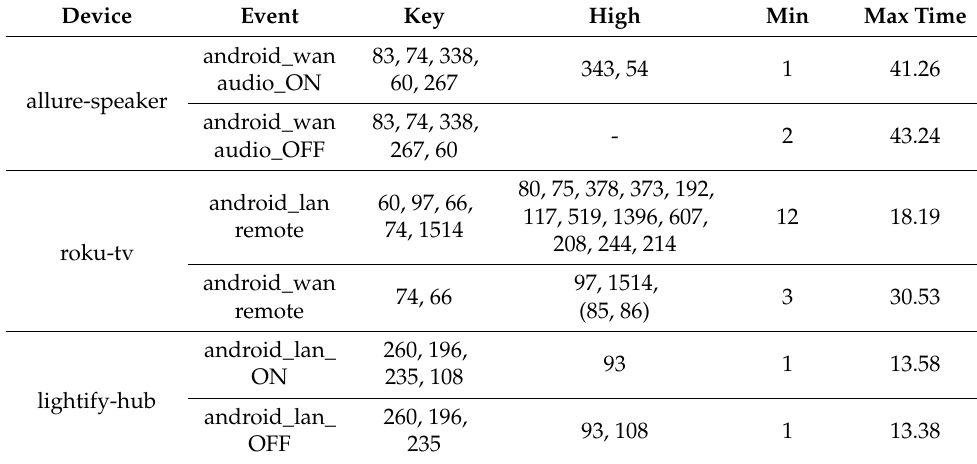
Table 9. MonIotr datasets